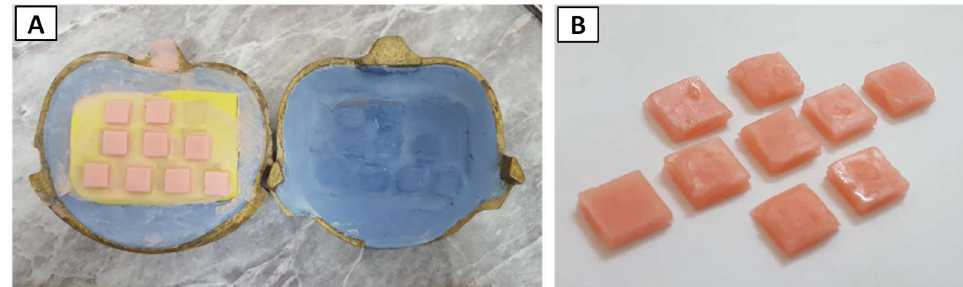
Figure 2. Soft liner specimens after curing ( A ) within the molds and ( B ) outside the